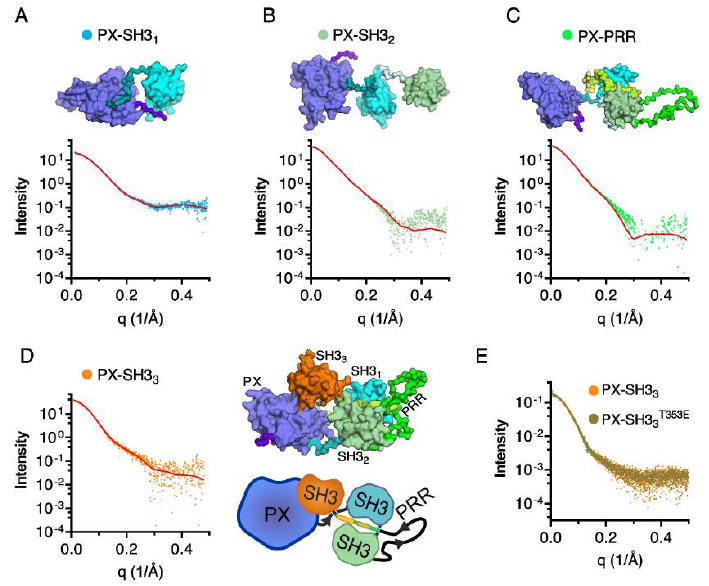
Figure 6. SAXS-based rigid body modeling of Tks4 fragments. Experimental scattering curves and computed scattering intensity generated by CORAL for the Tks4 fragments PX–SH3 1 ( A ), PX–SH3 2 ( B ), PX–PRR ( C ), and PX–SH3 3 ( D ) are shown in black and red, respectively. Atomic models were generated based on the 1UEC, 1WLP, and 1GD5 structures using MODELLER. Domains and linker regions are shown in different colors to guide the eyes (PX: blue, SH3 1 : cyan, SH3 2 : light green, PRR: lime and green, SH3 3 : orange.) The schematic representation of the autoinhibited structure of the full N -terminal region is shown in panel D ( E ) Scattering curves of the T353 mutant and wild-type PX–SH3 3 constructs.